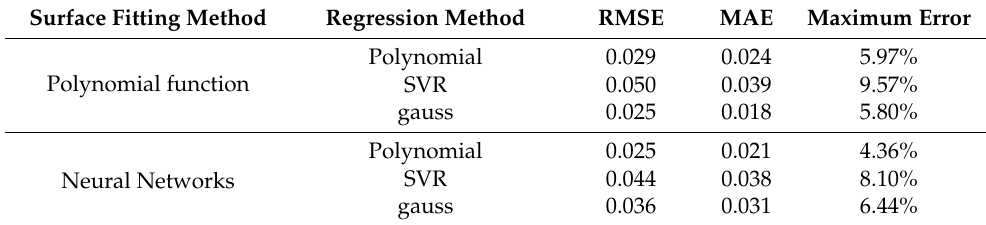
Table 7. Analysis of regression